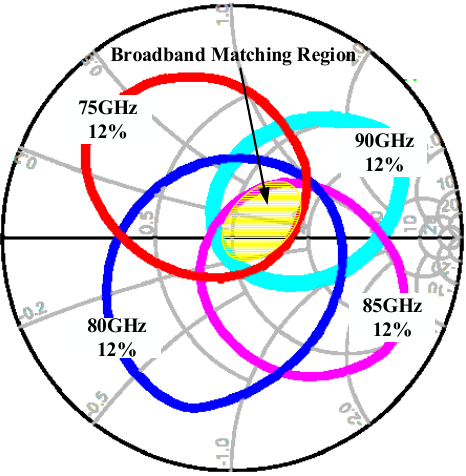
Figure 5. Output load-pull for a 12% efficiency at different input frequencies.